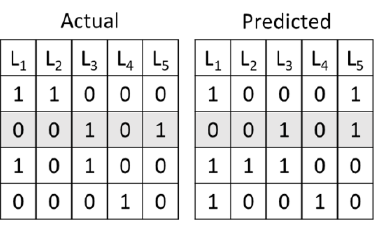
Figure 4. Example of subset accuracy.